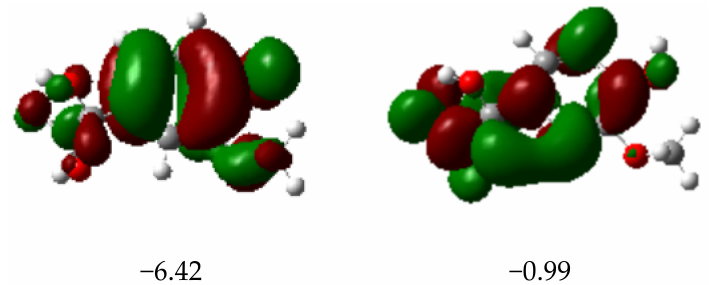
Figure 4. HOMO and LUMO energies [eV] distribution in mandelic acid and its derivatives in vacuum calculated at B3LYP/6-311++G (d,p) level of theory.